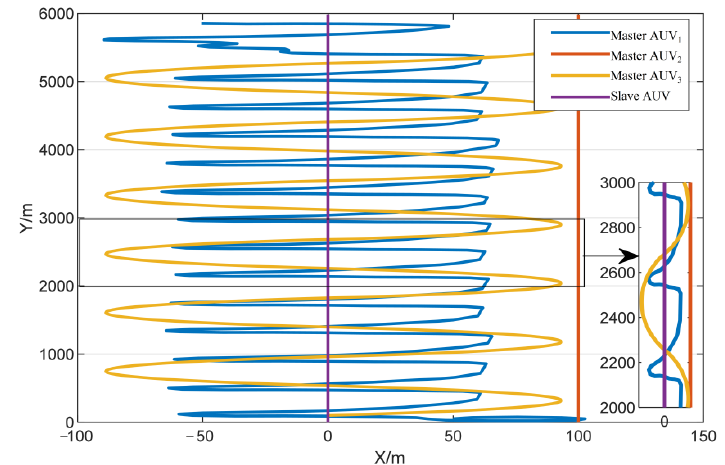
Figure 9. Master and slave AUV paths.